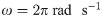
Global frequencies Ω and perturbation response rates σ for three coupled DPLLs.(A) Collective frequency Ω as a function of the transmission delay τ for the in-phase (blue), m-twist with m = 1, 2 (red), and checkerboard (green) synchronized states, as determined from Eqs (10) and (20). Solid lines indicate stable solutions, dotted lines indicate unstable solutions. (B) Perturbation response rate σ, Eq (17), as a function of Ωτ for different synchronized states in a ring of 3 coupled DPLLs (color code as in panel A). (C) Perturbation response rate σ as a function of Ωτ for different synchronized states in a chain of 3 coupled DPLLs (color code as in panel A). All results are shown for a system of identical PLLs with ω=2πrads-1, K = 0.1ω, p^ given by Eq (29) with a = 1 and ωc = 0.01ω.